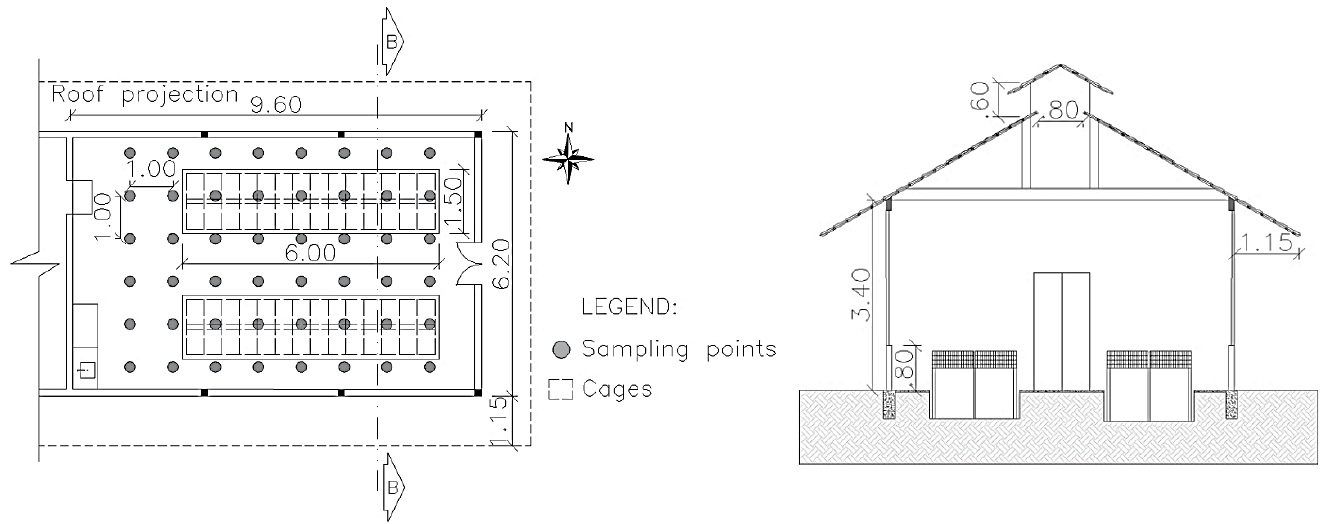
Figure 1. Rabbit house scheme. ( Left ) Floor plan of the rabbit house and position of sampling points. ( Right ) Cut BB of the rabbit house section. Source: adapted from [11,14].